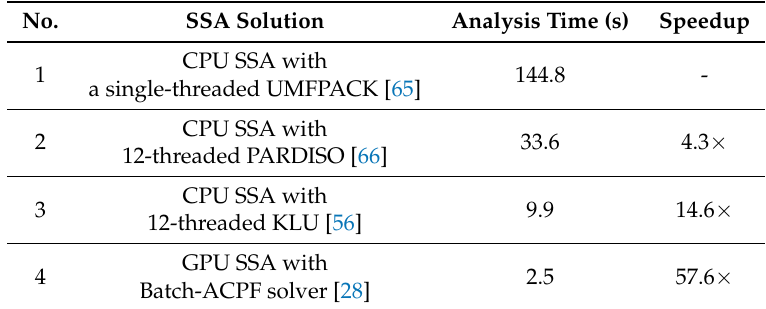
Table 2. Performance comparison in [28]. All the other speedups were calculated against the analysis time of No. 1.